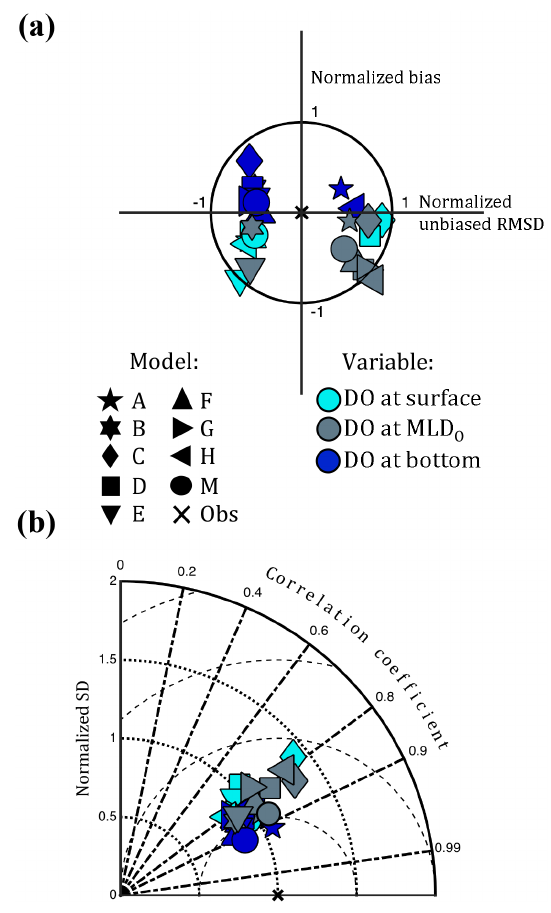
Figure 4. Normalized summary (a) target and (b) Taylor diagrams illustrating model skill of dissolved oxygen at the surface, MLD O , and bottom for 13 Chesapeake Bay stations in 2004–2005. The “x” represents the skill of a model that perfectly reproduces the obser- vations. The dotted, dashed-dot, and dashed lines on the Taylor dia- gram represent lines of constant standard deviation, correlation co- efficient, and unbiased RMSD,